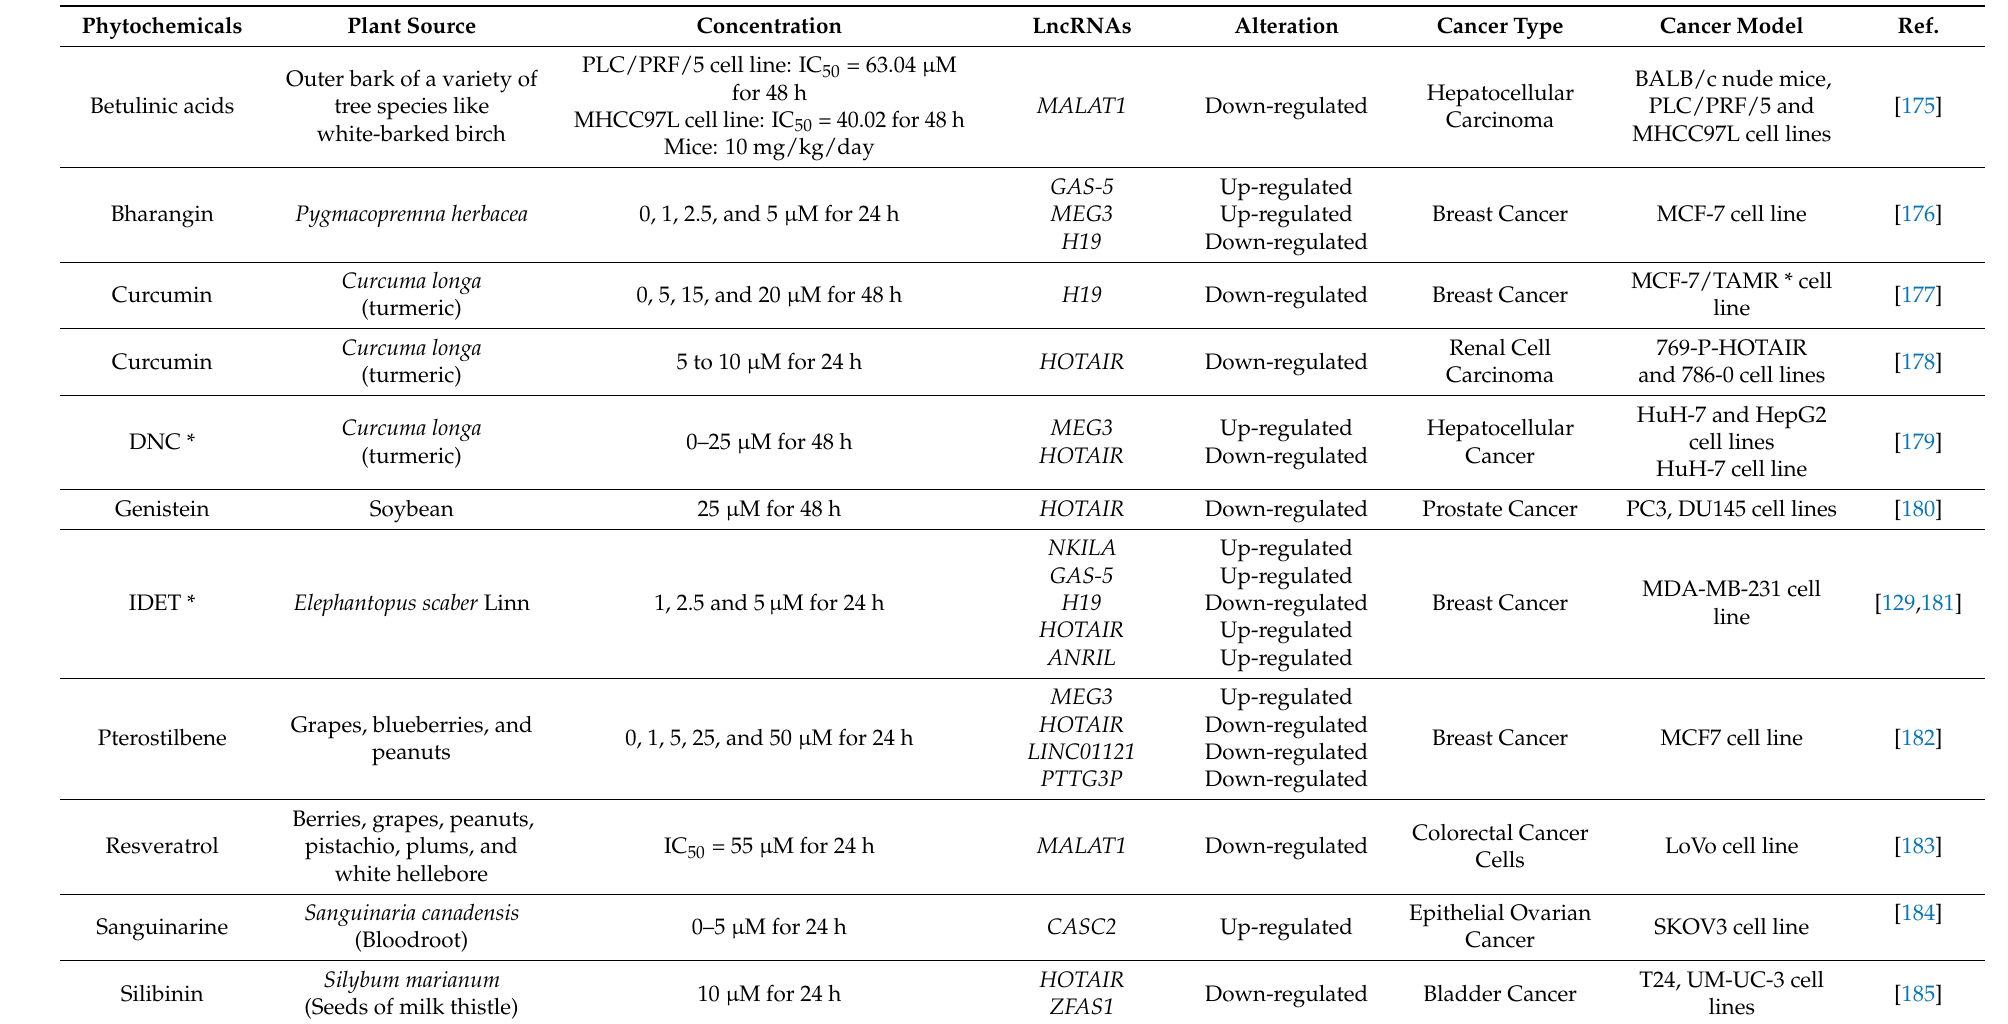
Table 1. Phytochemicals targeting LncRNAs to inhibit cancer